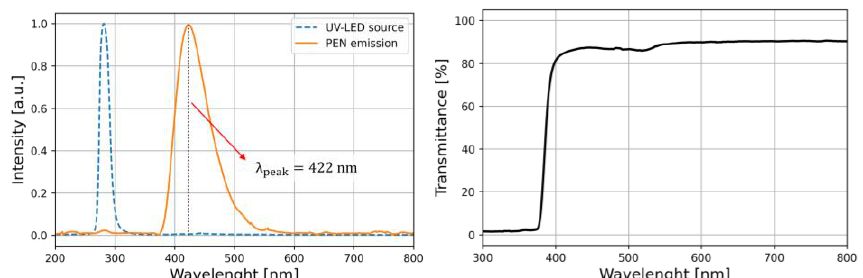
Figure 4. ( Left ): Emission spectrum of the PEN scintillator (orange) stimulated by a UV LED source (blue dashed curve). ( Right ): PEN transmittance relative to air as a function of the wavelength.